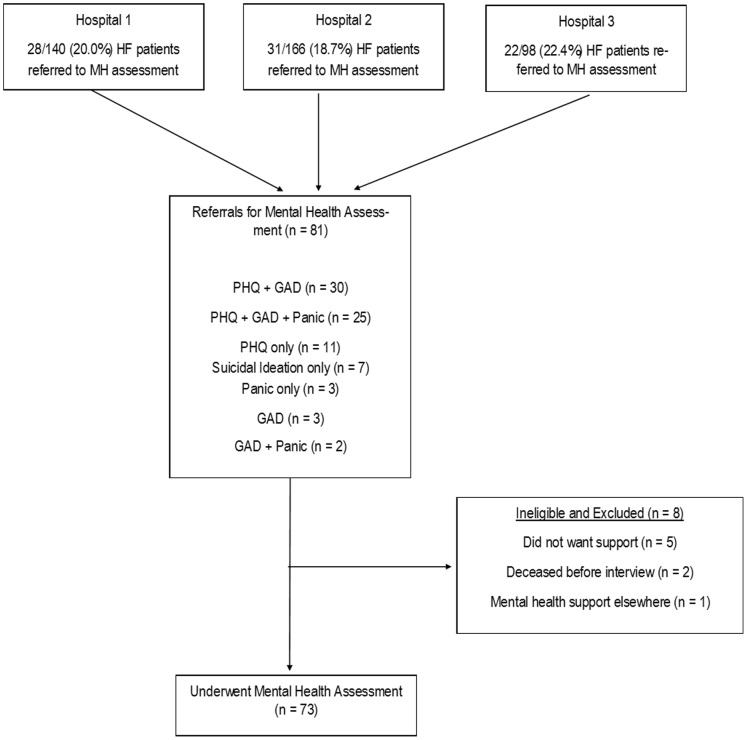
Flow chart of patients through the study.